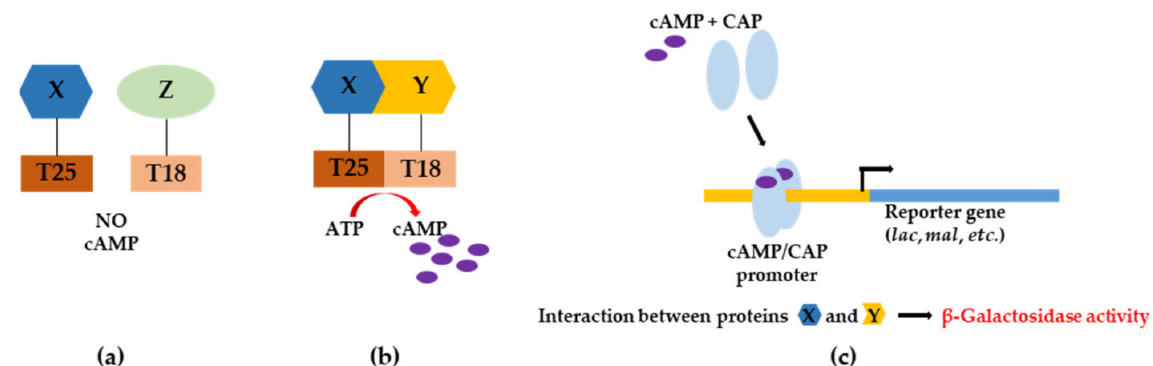
Figure 10. Scheme illustrating the principle of the BACTH assay. ( a ) Proteins T25-X and T18-Z that do not interact will not reconstitute adenylate cyclase activity. ( b ) Proteins T25-X and T18-Z that interact will reconstitute adenylate cyclase activity leading to production of cAMP. ( c ) Cyclic adenosine monophosphate (cAMP) bound to catabolite activator protein (CAP) positively regulates β -galactosidase